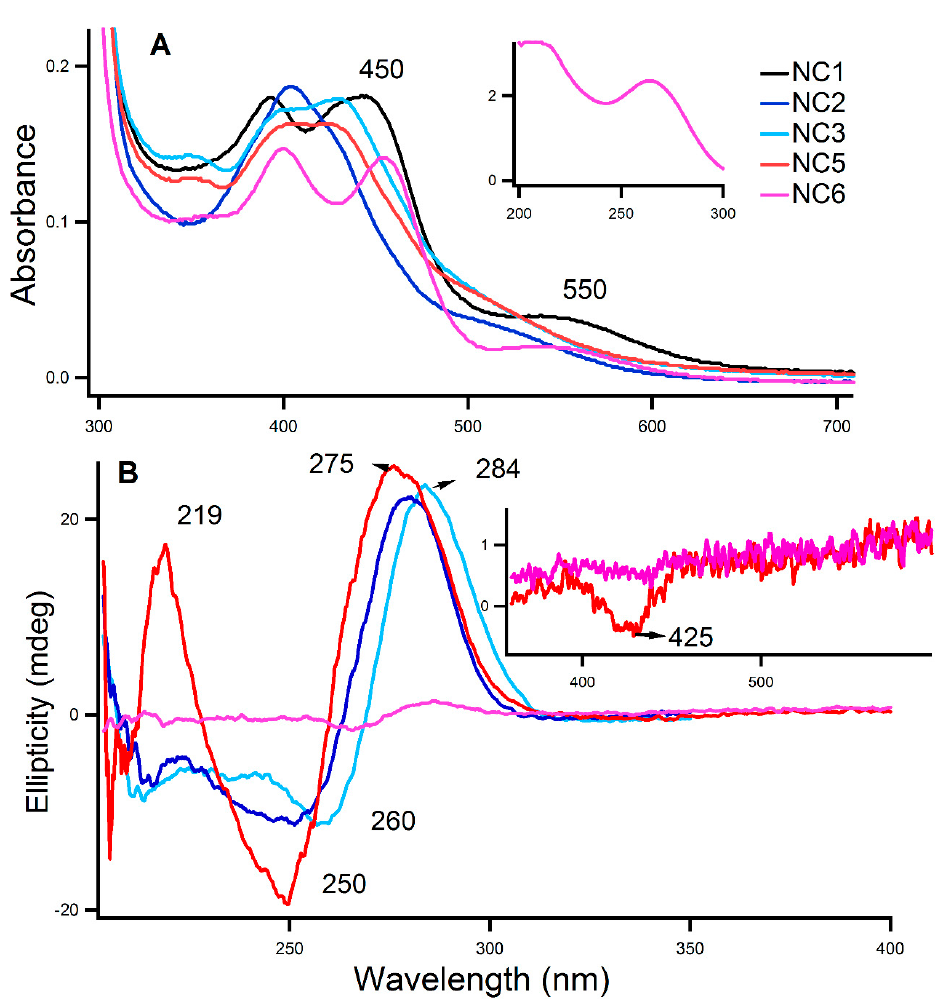
Figure 1. Absorption ( A ) and circular dichroism ( B ) spectra of aptamer-templated silver nanoclusters in water. The inset in 1A shows the absorption of the NC6 oligonucleotide in the UV region. 1B inset highlights the induced CD of NC5 in the visible region. [DNA] = 15 µ M, [AgNO 3 ] = 90 µ M, and [NaBH 4 ] = 90 µ M. The sequences of the DNA in NC1, NC2, NC3, NC5, and NC6 samples are provided in the experimental section.